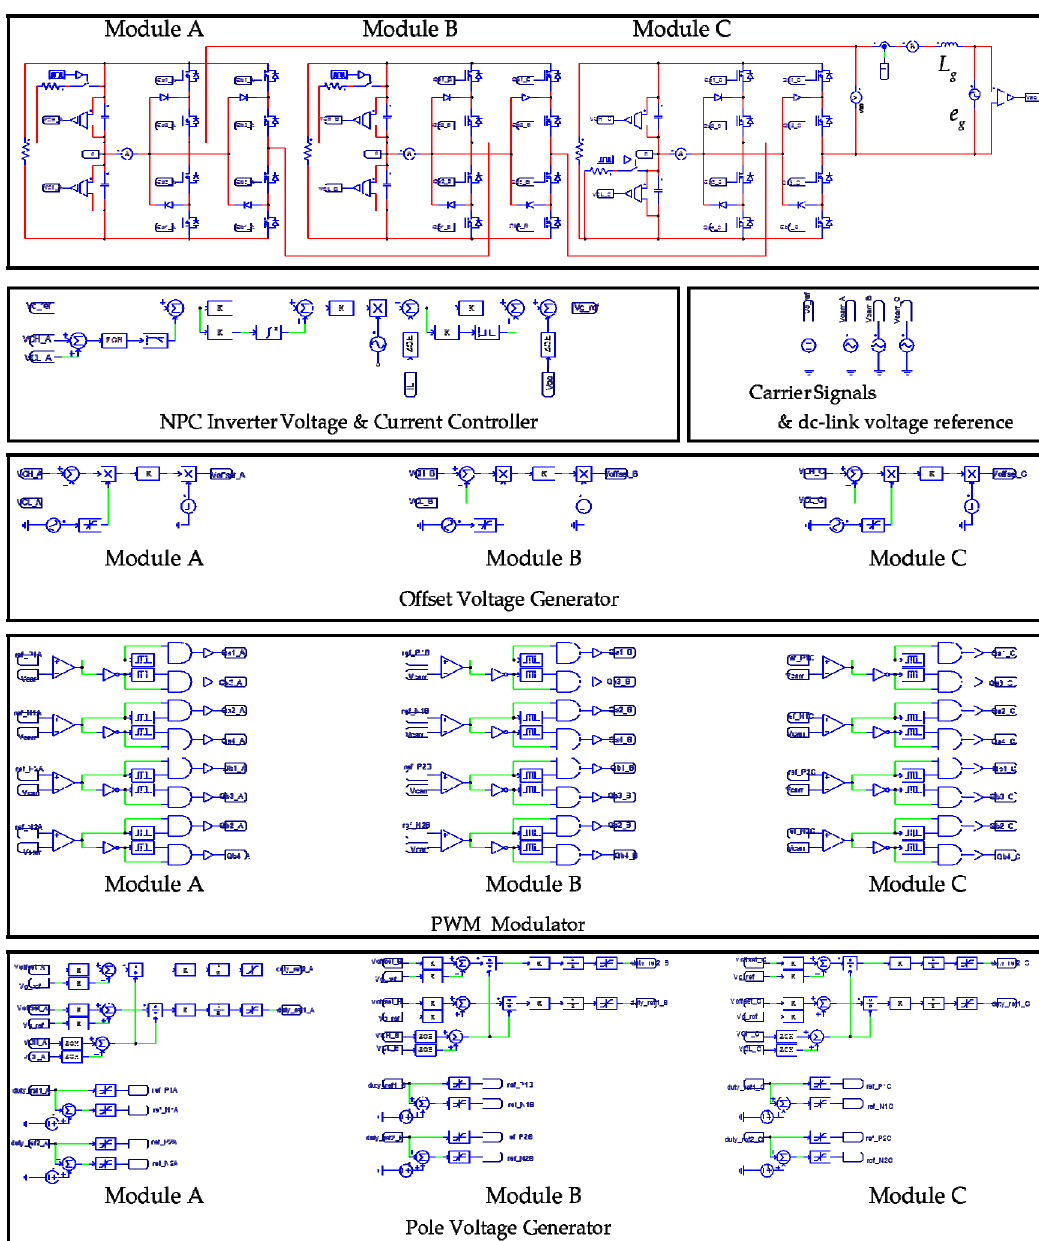
Figure 4. Proposed multi-level NPC inverter control block with offset voltage generator.